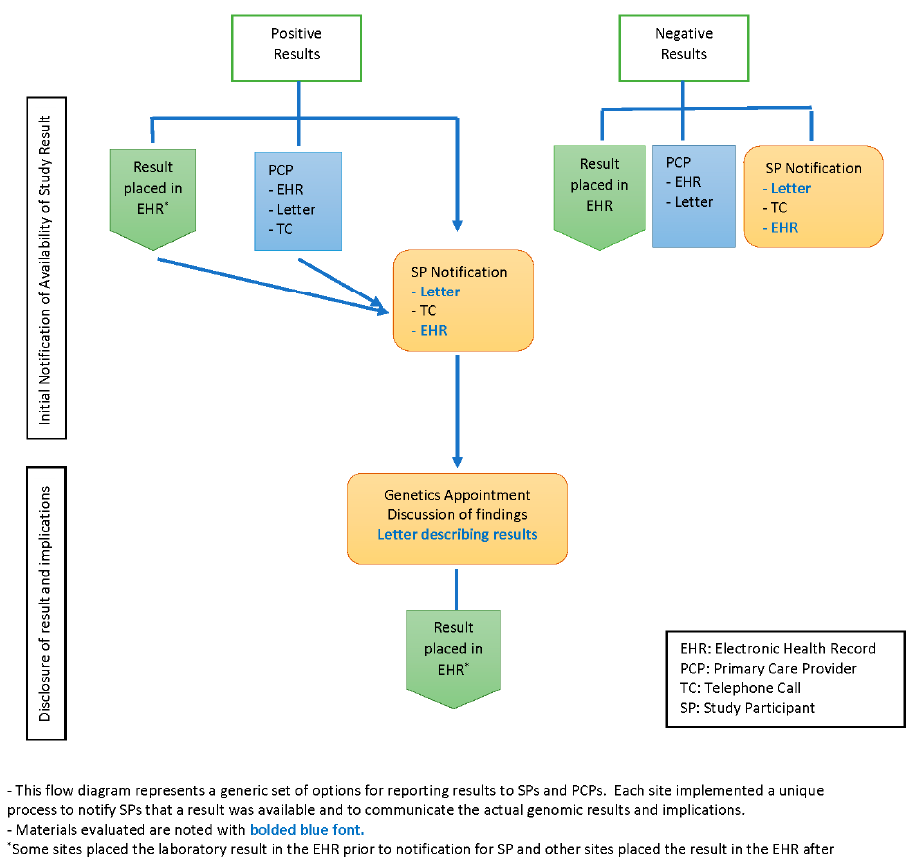
Figure 1. Flow diagram of return of result sequences for positive and negative results.